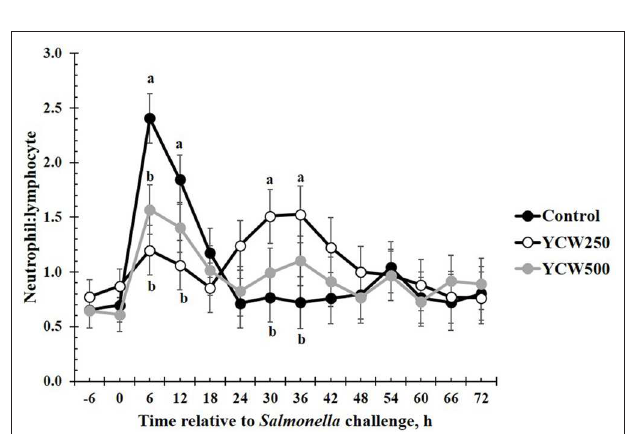
FIGURE 6 | The neutrophil:lymphocyte ratio measured in pigs fed a control (Control) diet or supplemented with a yeast cell wall at 250 mg/kg (YCW250) or 500 mg/kg (YCW500), following administration of an oral Salmonella Typhimurium challenge on d 19. ab Treatments differ P < 0.03.